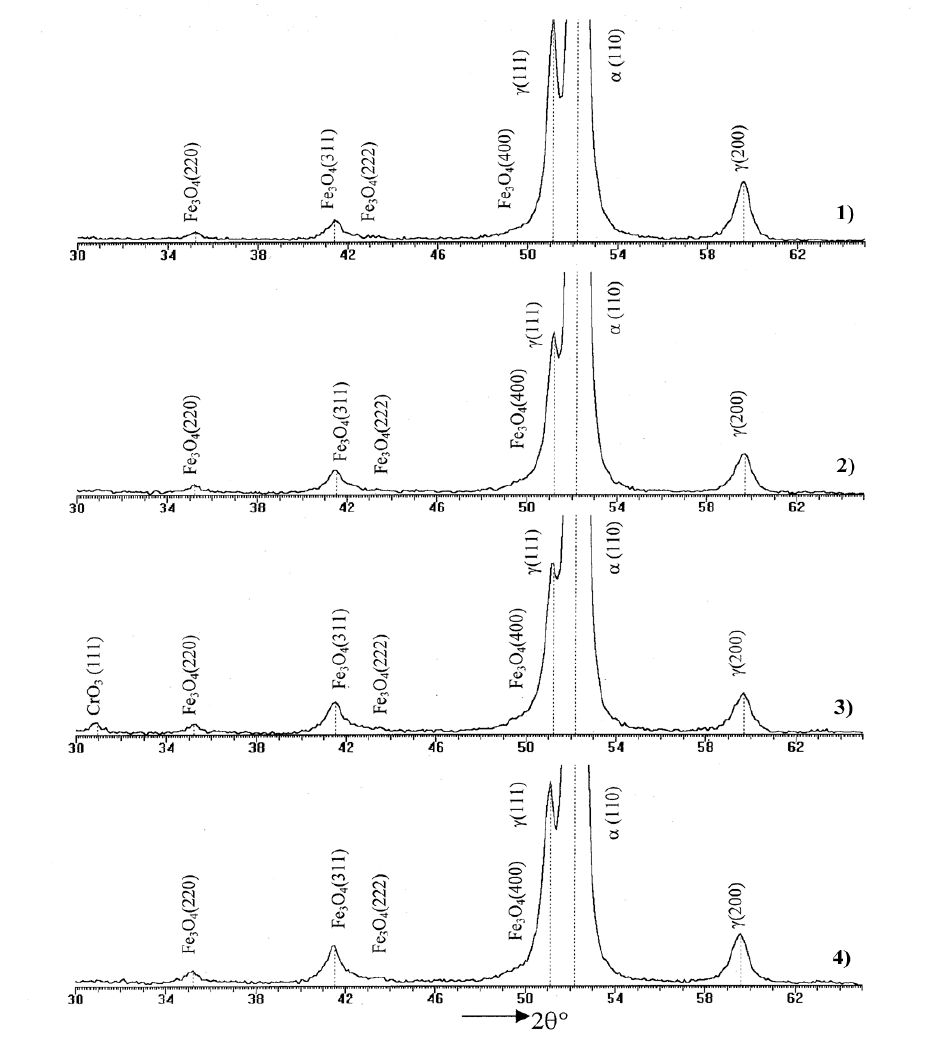
Fig. 5. Fragments of XRD patterns (CoK  ) from surface layers of gas-thermal coatings obtained under modes